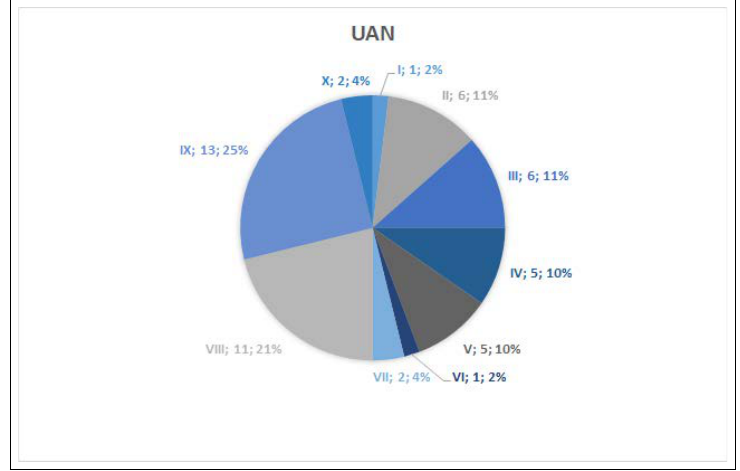
Figure 7. Answers to question 4 What is not clear to you? given by UAN group.